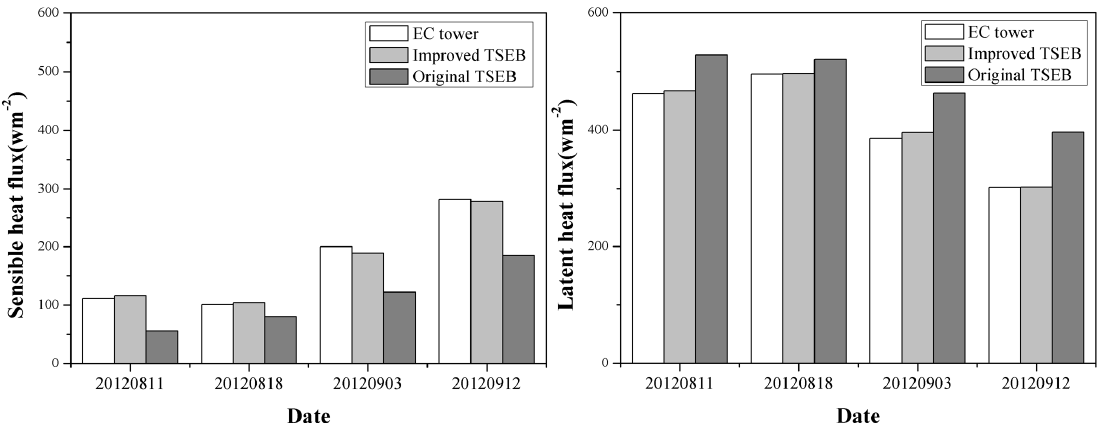
Figure 6. Comparisons of the sensible and latent heat fluxes obtained from the improved and original TSEB models with tower-based measurements.